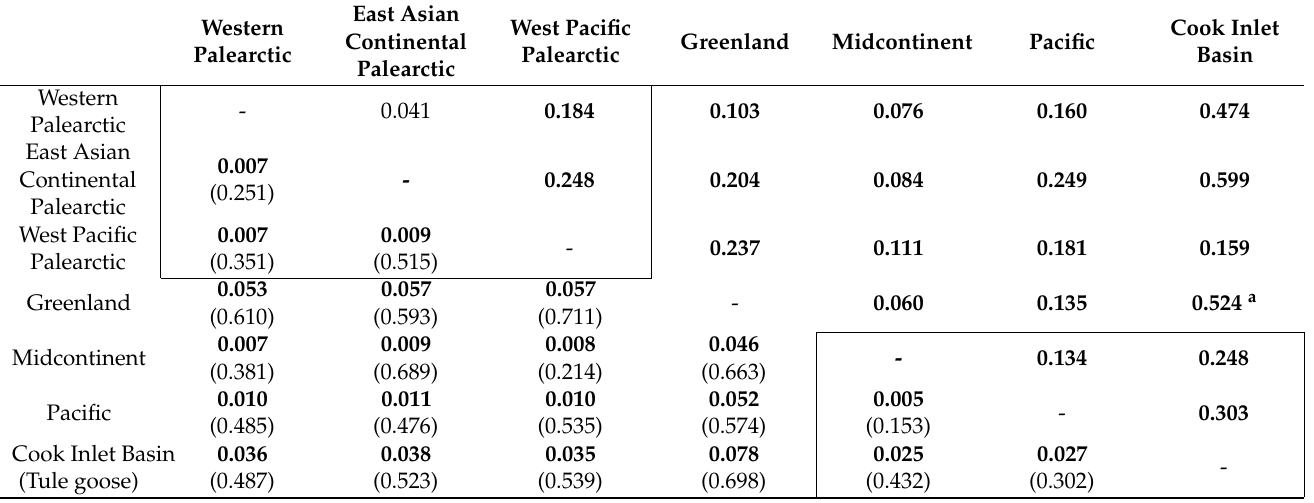
Table 2. Pairwise Φ ST values calculated from 3888 ddRAD-seq loci (below diagonal) with highest value for an individual locus in parentheses, and Φ ST values for the mtDNA control region (above diagonal) for greater white-fronted goose management units. Values within boxes indicate estimates within the same continent. Significant values for mtDNA ( α = 0.05) and ddRAD-seq loci ( α = 0.01) are indicated in bold text. See Supplemental Figure S1 divergence estimates among individual nesting